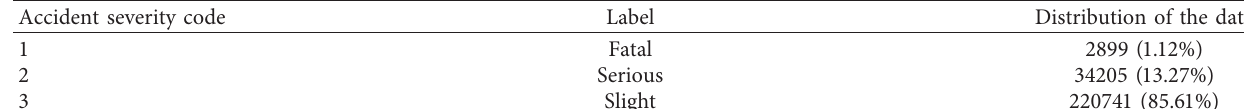
Table 2: Categorization criteria for traffic accident severity.